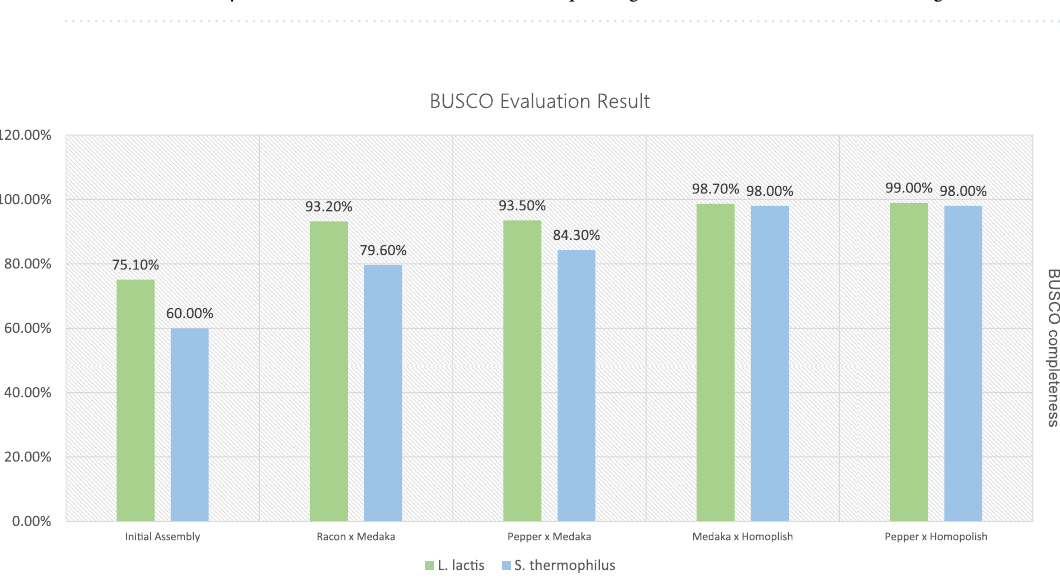
Table 7. Summary statistic of the L. lactis and S. thermophilus genomes after circularization using Circlator.